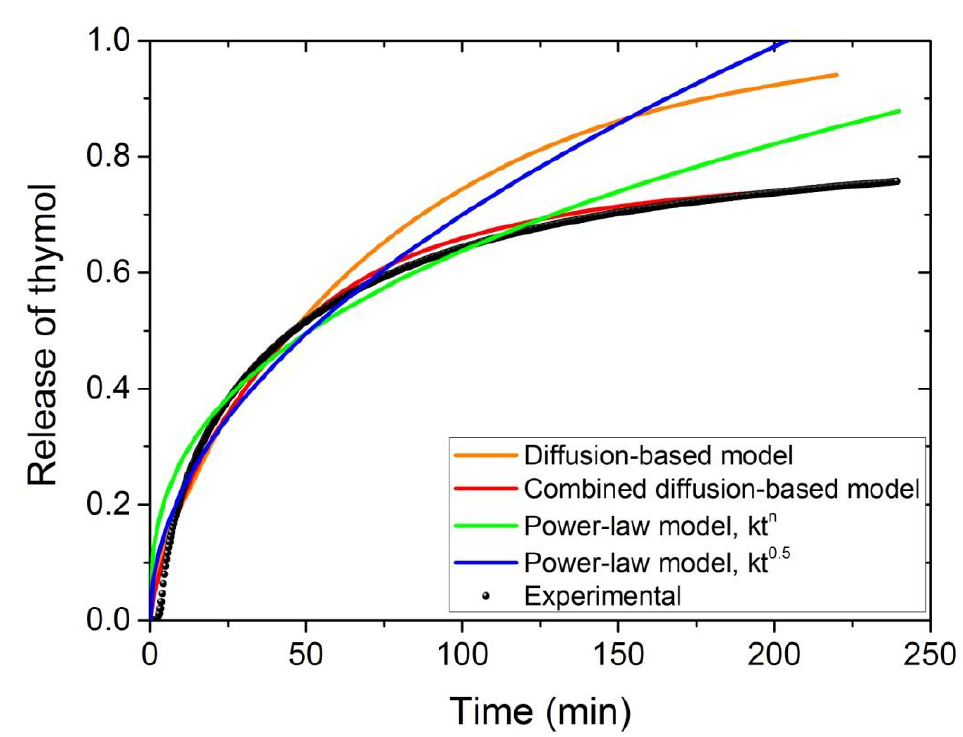
Figure 10. Comparison of different models in the simulation of the experimental data on the release profile of thymol at 142 °C. The diffusion model is based on Equation (6), the combined diffusion model on Equation (10) the power-law model on Equation (11), whereas in the last simulation (blue line) the same Equation (11) was used but setting the value of n fixed at 0.5. Table 4. Parameters estimated (i.e., fast, D f and slow, D s diffusion coefficients and fraction f ) from fitting of the